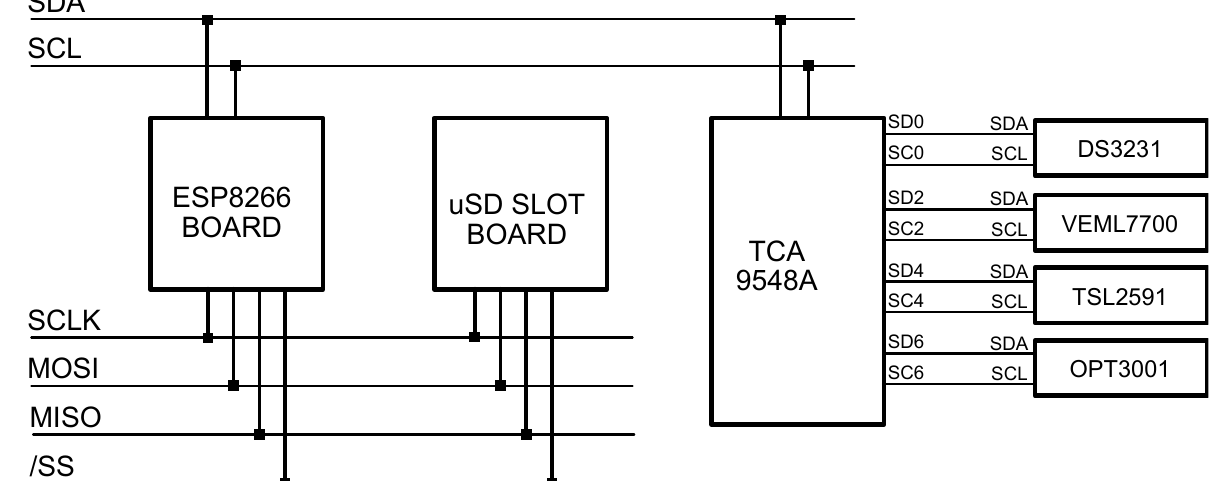
Figure 4. High-level circuit schematic of the PCB sensor board.